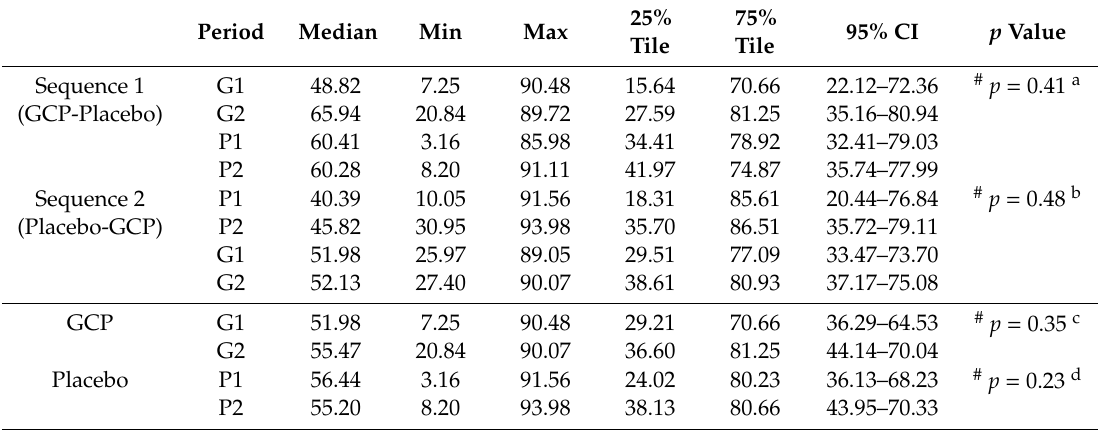
Table 7. VAS values for the question, “Are you satisfied with the moisture level of your